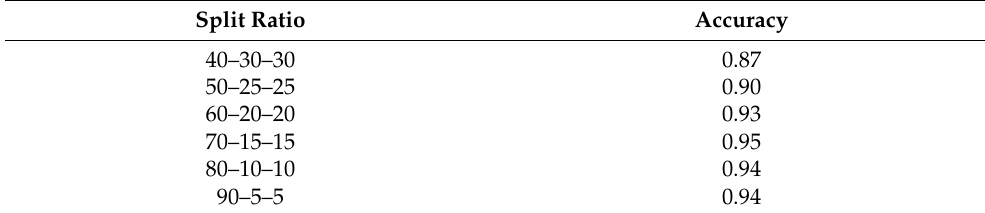
Table 2. Impact of different split ratio on the efficiency of proposed